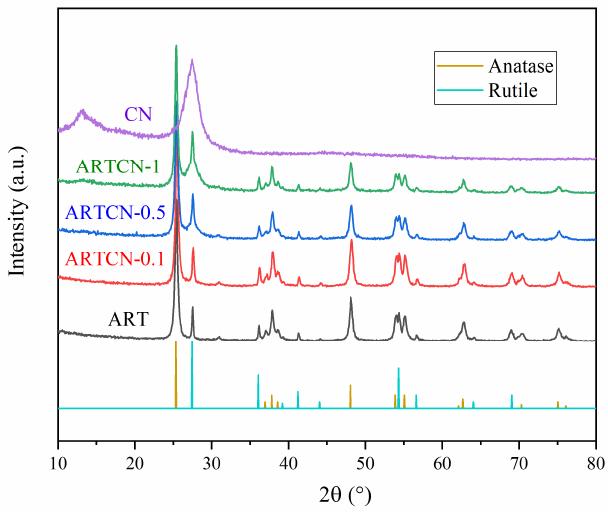
Figure 1. XRD patterns of the samples.